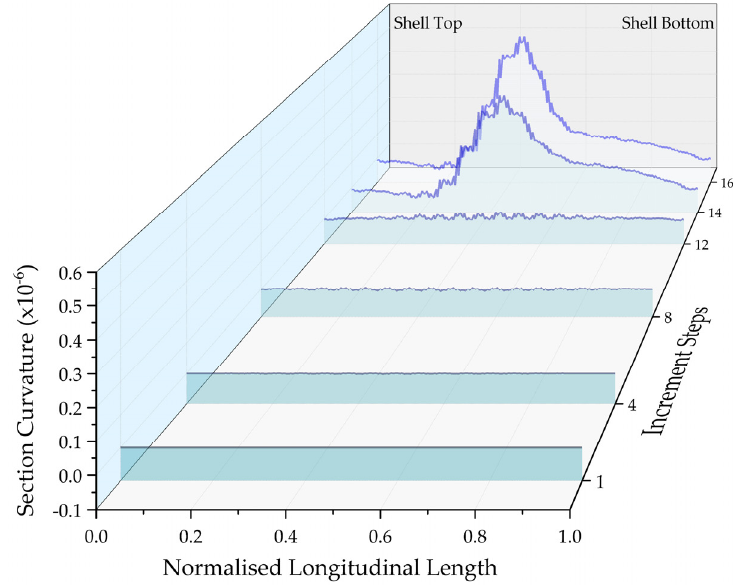
Figure 22. Shell (20 m at 24 mm) partially enlarged section curvature along the normalised longitudinal length at early increment steps, under the pure bending